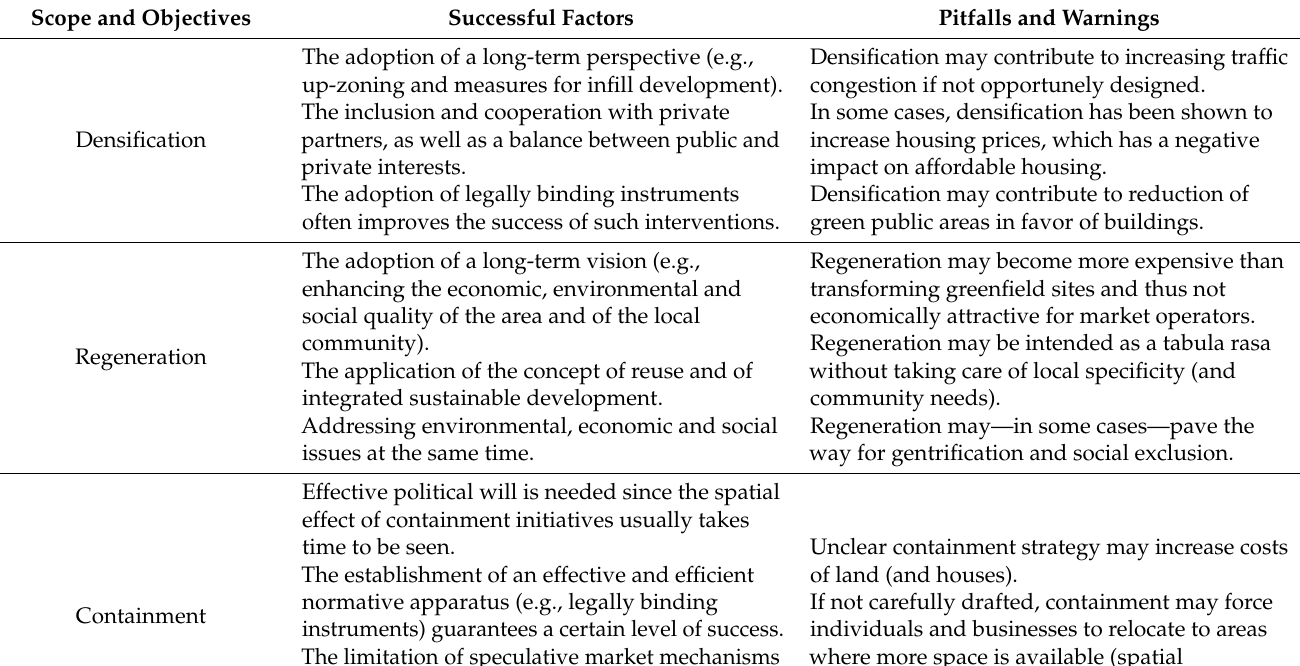
Table 4. Successful factors and pitfalls when it comes to promoting sustainable land use (authors’ own elaboration). Scope and